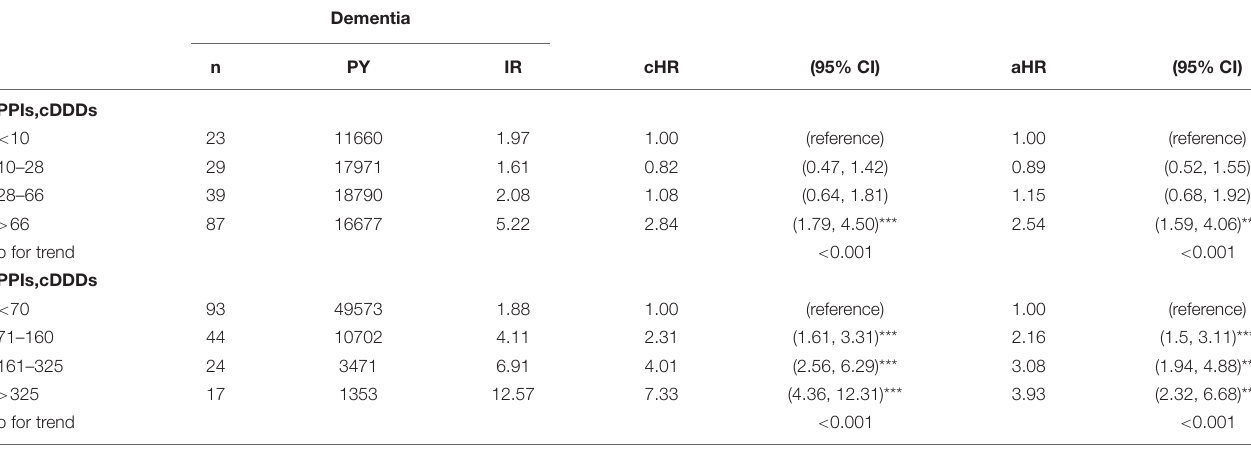
TABLE 6 | The effect of PPIS on GERD